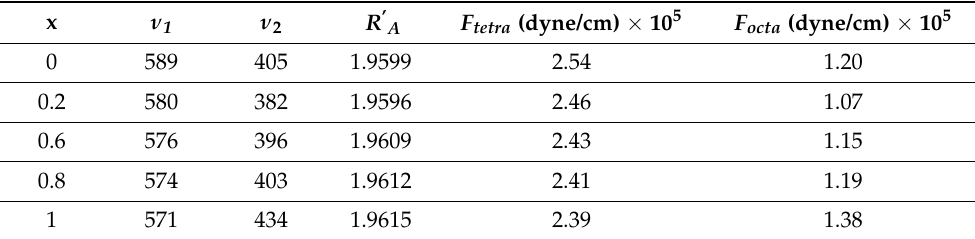
Table 4. ν 1 (the absorption spectra of the A-site) and ν 2 (the absorption spectra of the B-site), R’ A